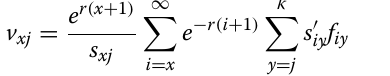
Table 2 Mean developmental time (d), hind tibia length (µm), and head width (µm) of Leptomastix dactylopii , when developed in different stages of Planococcus ficus